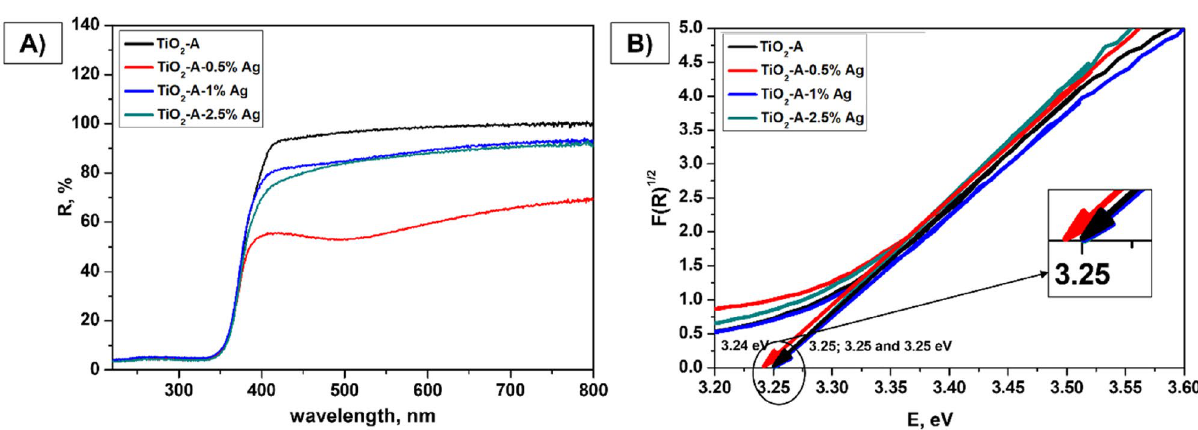
Figure 5. Diffuse reflectance UV–Vis spectra ( A ) and Tauc spectra ( B ) at wavelengths from 220 to 800 nm of TiO 2 -A-n%